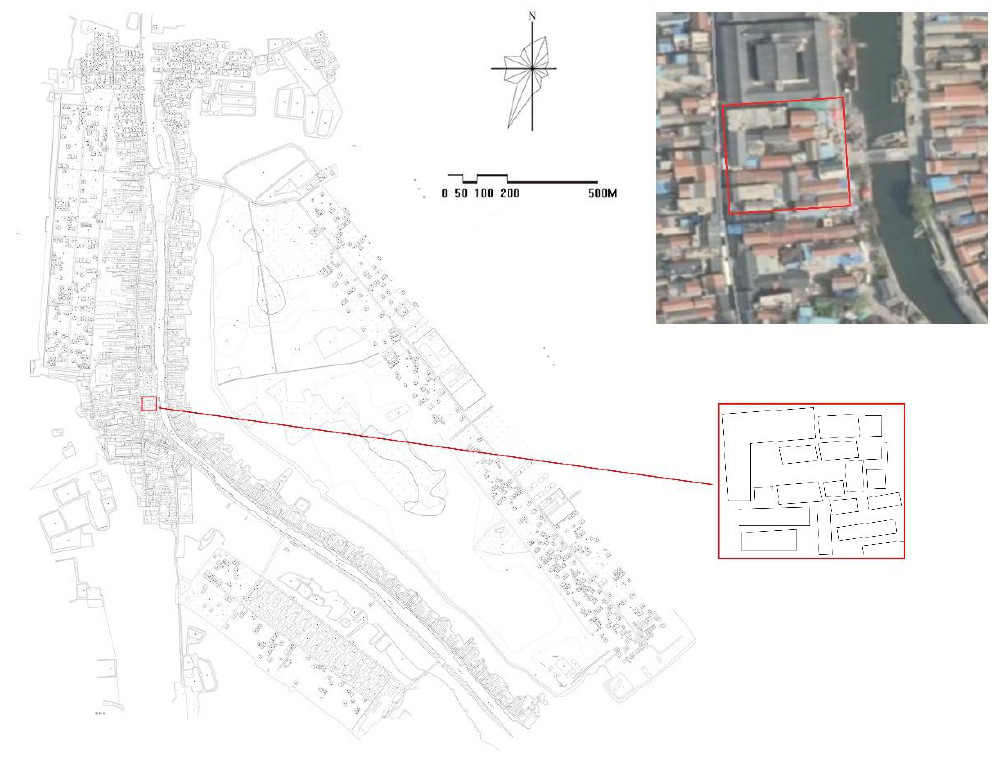
Figure 5. The Current situation map of Nanyang (Source: Nanyang town government).